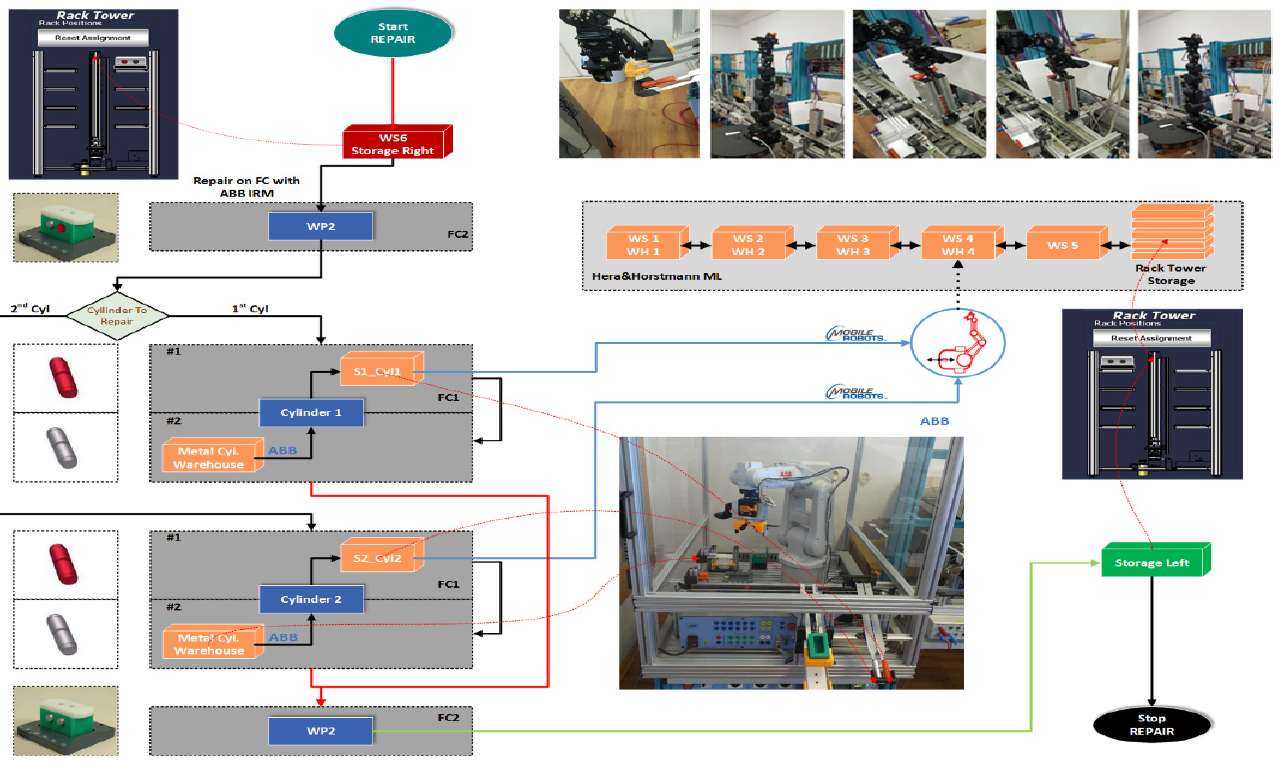
Figure 11. Repair task